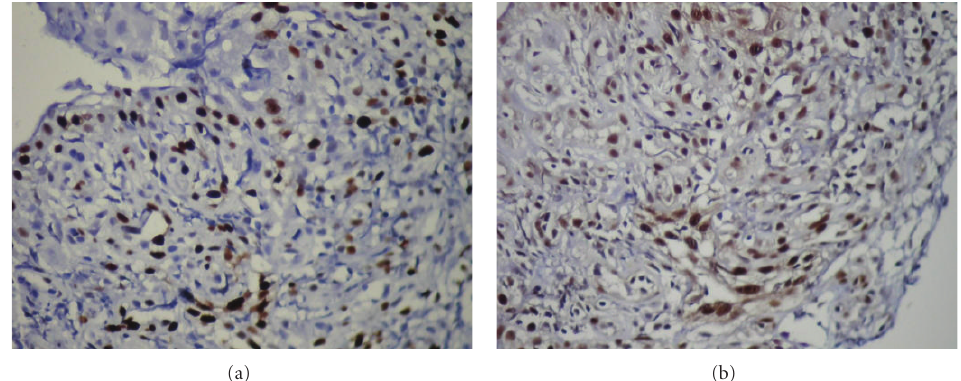
Figure 7: (a) The expressions of Ki-67 in lining epithelium of radicular cysts (Ki-67 × 40). (b) The expressions of MCM-2 in lining epithelium of radicular cysts (MCM-2 ×